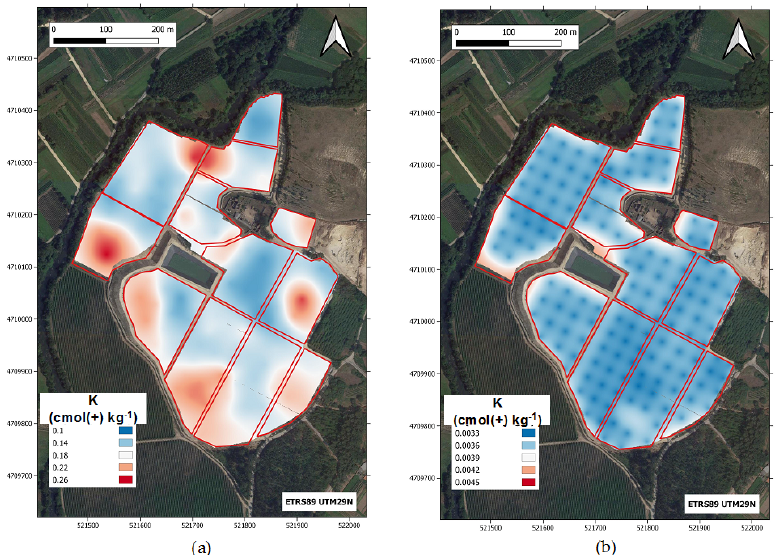
Figure 9. Estimation ( a ) and error ( b ) maps of potassium content over the experimental vineyard generated by ordinary kriging.